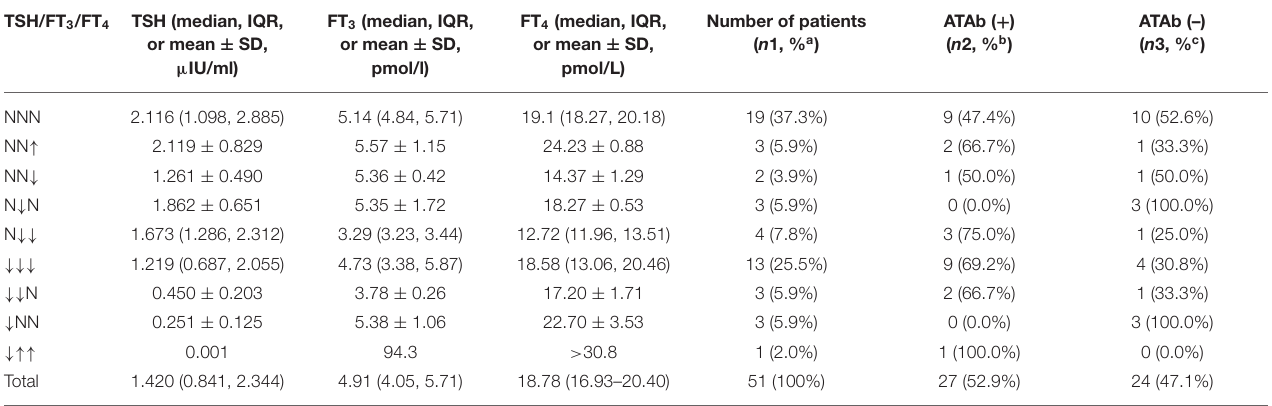
TABLE 1 | Results of thyroid hormone test on admission. TSH/FT 3 /FT 4 TSH (median, IQR, or mean ±